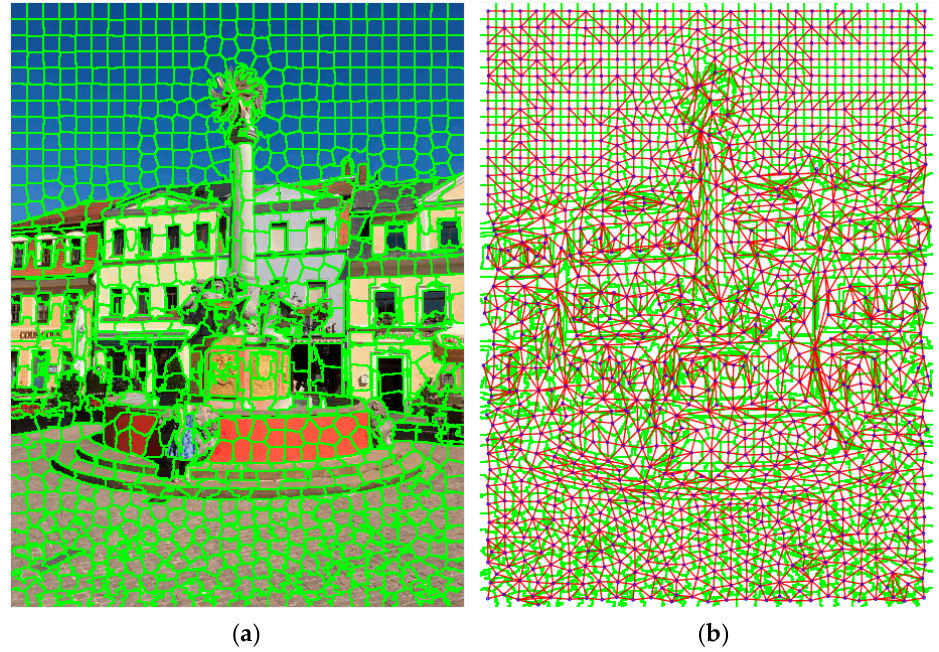
Figure 9. An example of superpixel segmentation for an image: ( a ) Overlay display of the origin image and the corresponding superpixel segmentation result; ( b ) The RAG corresponding to superpixels.